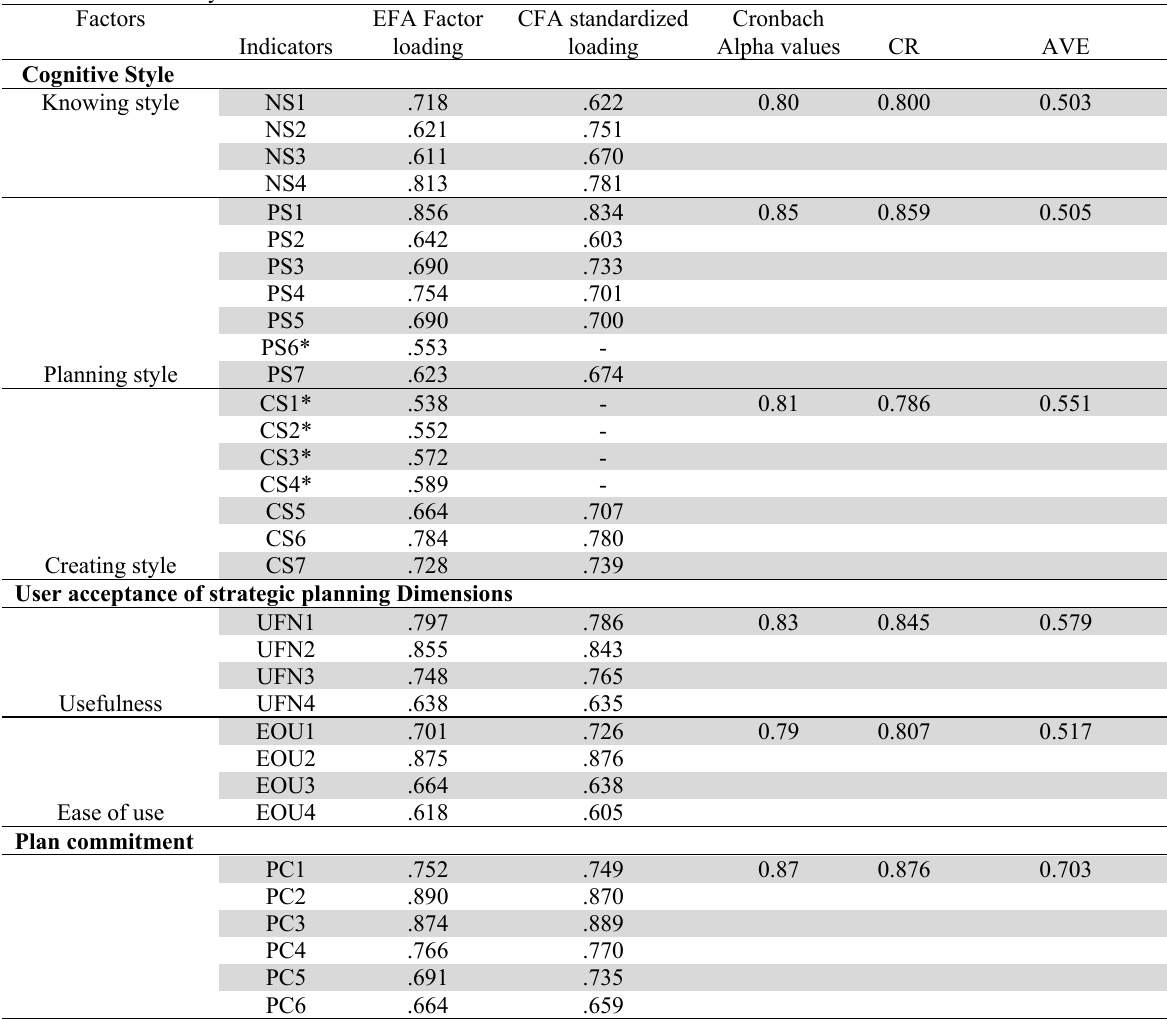
Measurement accuracy